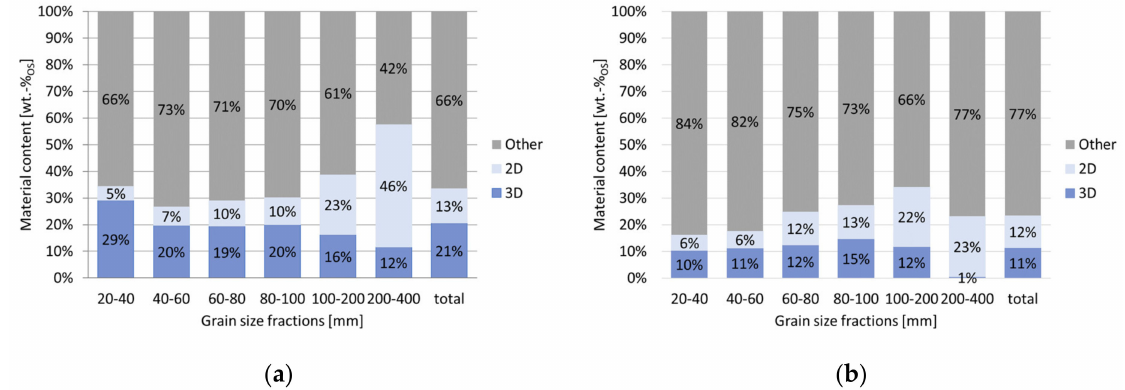
Figure 9. Content of plastics-2D and plastics-3D in mixed commercial waste ( a ) and mixed municipal waste ( b ) in different particle sizes